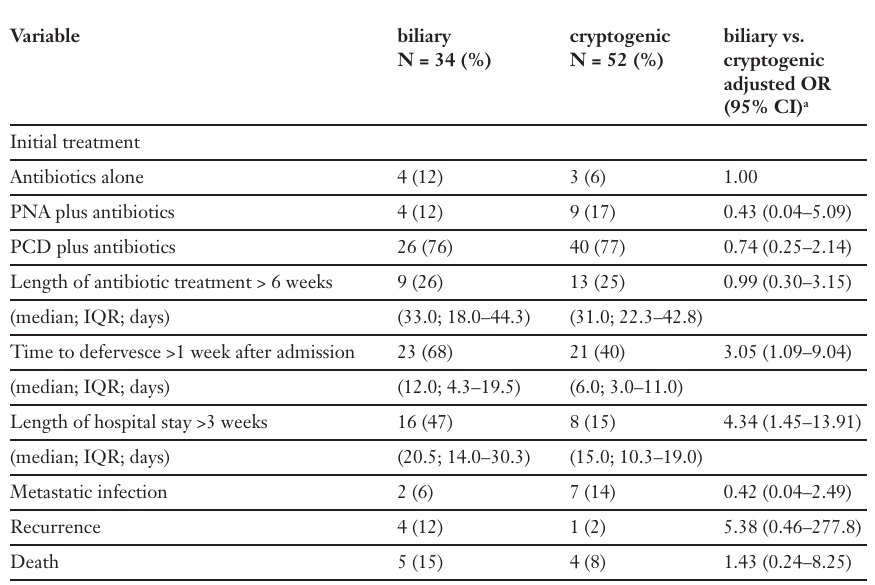
Treatment and out- come in the biliary and cryptogenic